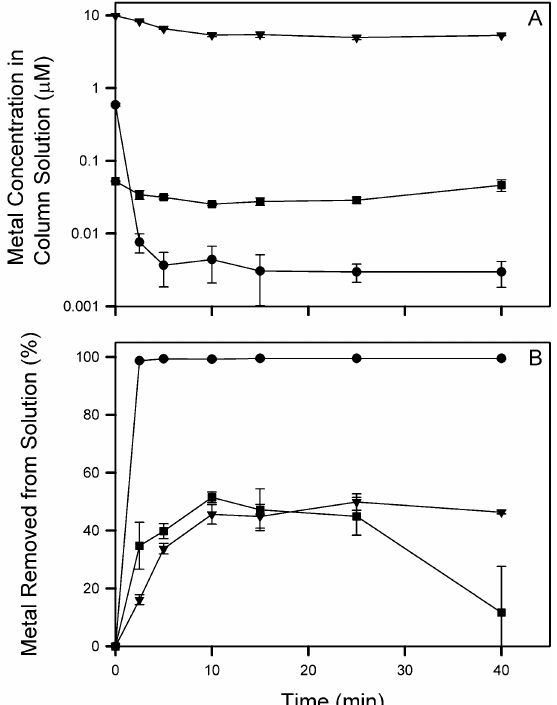
Figure 6. Column solution concentration ( A ) and percent metal removed from solution ( B ) during flotation ( φ = 10) of Cs + ( ▼ ), Cd 2+ ( ● ), and La 3+ ( ). The 40 min data were collected after sparging ceased and column foam collapsed. Symbols represent mean and standard deviation values from triplicate columns (n = 3).